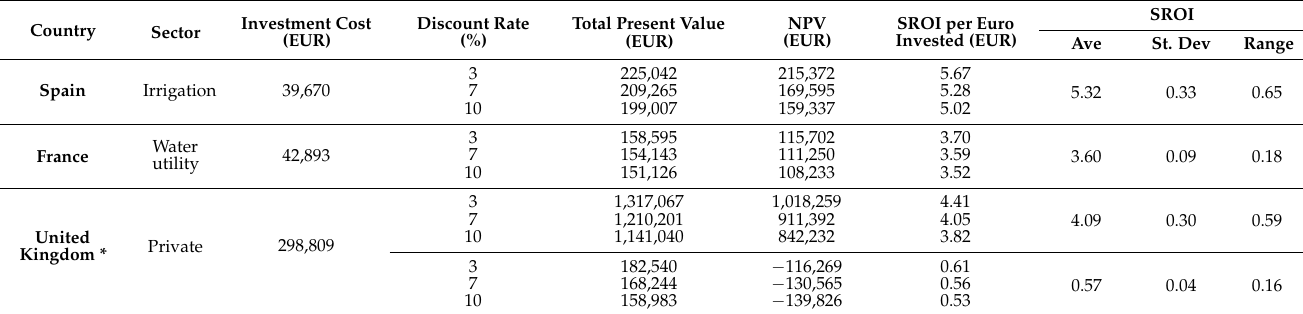
Table 9. Sensitivity of the SROI results to MHP O&P impact.